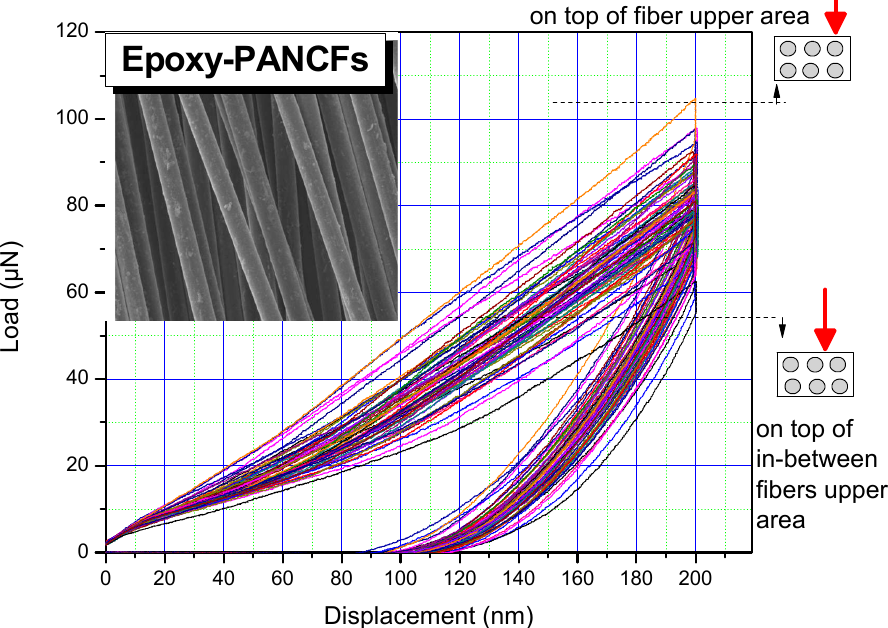
Figure 5. Load-displacement data from the loading-unloading mapping measurements at 200 nm of displacement, for the epoxy-PANCFs sample.